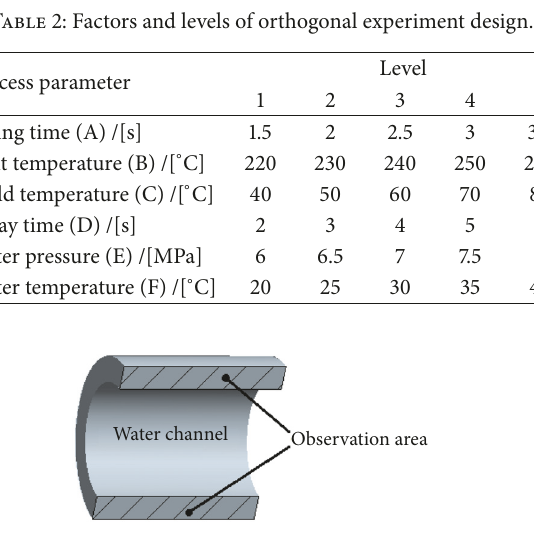
Figure 3: Schematic representation of specimen preparation for SEM observation.